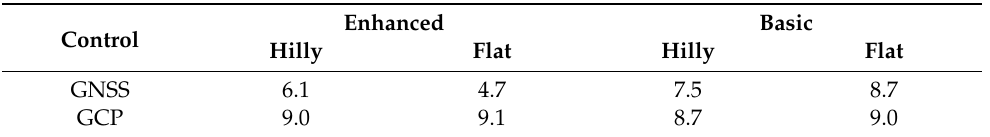
Table 7. Ratio between average principal distance RMSE for LC, HLC, L and HL configurations and average principal distance RMSE for LCO, LO, HLCO and HLO configurations for different terrain types, block control type and